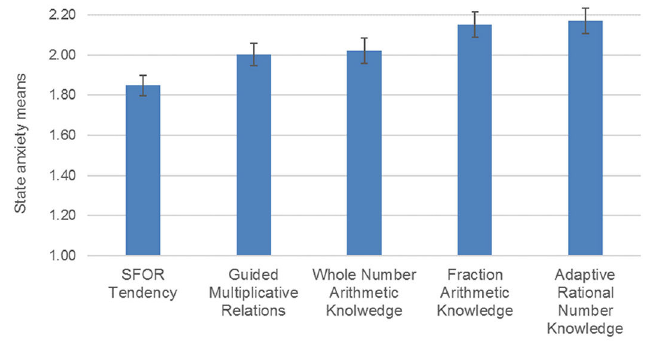
Means for State Anxiety on Each Task With Error Bars